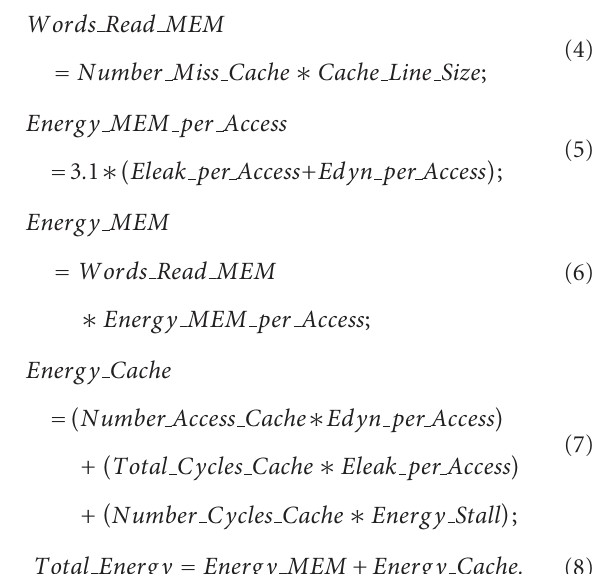
due to one miss in the cache ( Penalty ). The last value is calculated based on the cache line size in bytes. The